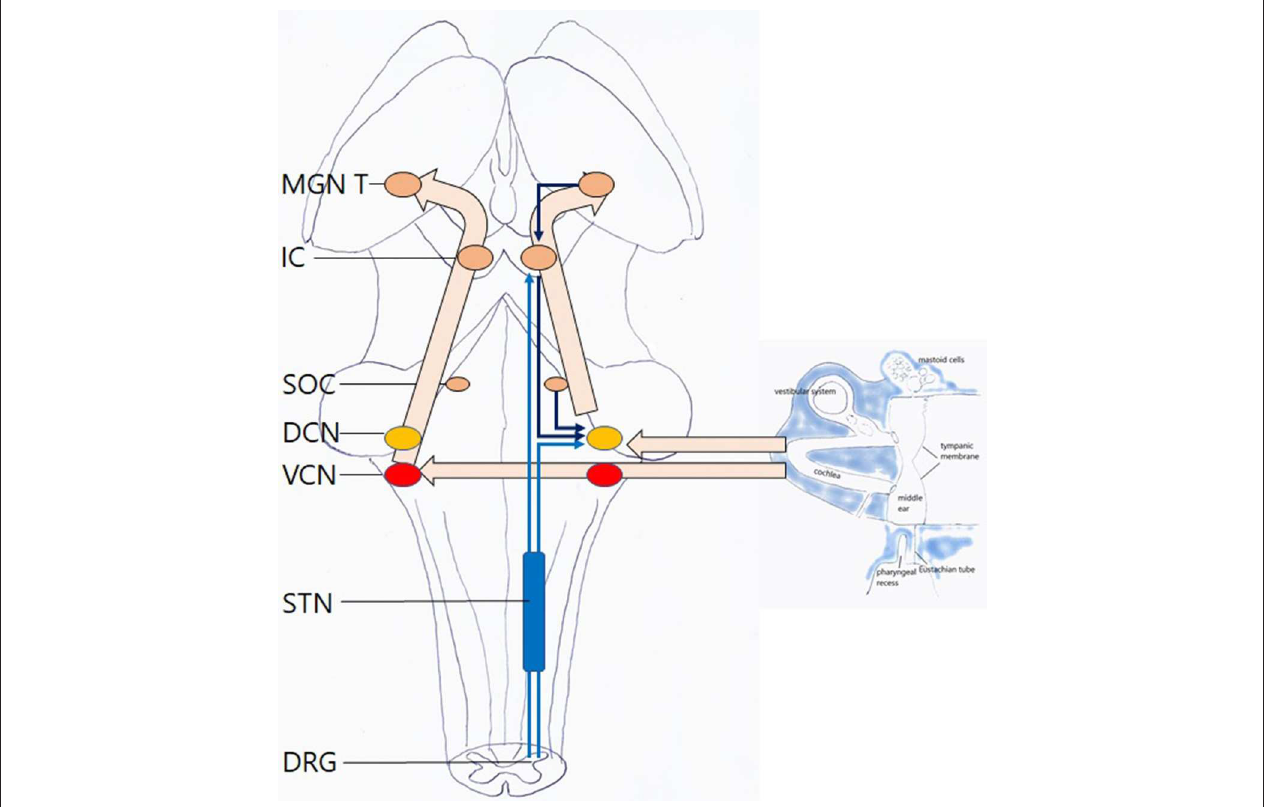
FIGURE 5 | Hearing: this is an automatic, passive process. Left hollow arrows: ventral pathway via the VCN. Right hollow arrows: dorsal pathway via the DCN with afferent and efferent inputs. Light blue arrows: somatosensory input to the dorsal pathway, with cervical and trigeminal origin, via the trigeminal nuclei. Dark blue arrows: central input to the dorsal pathway MGN medial geniculate nucleus of thalamus; IC inferior colliculus; SOC superior olivary complex; DCN dorsal cochlear nucleus; VCN ventral cochlear nucleus; STN spinal trigeminal nucleus; DRG dorsal root ganglia. For clarity sake, midline crossings and several descending pathways have been